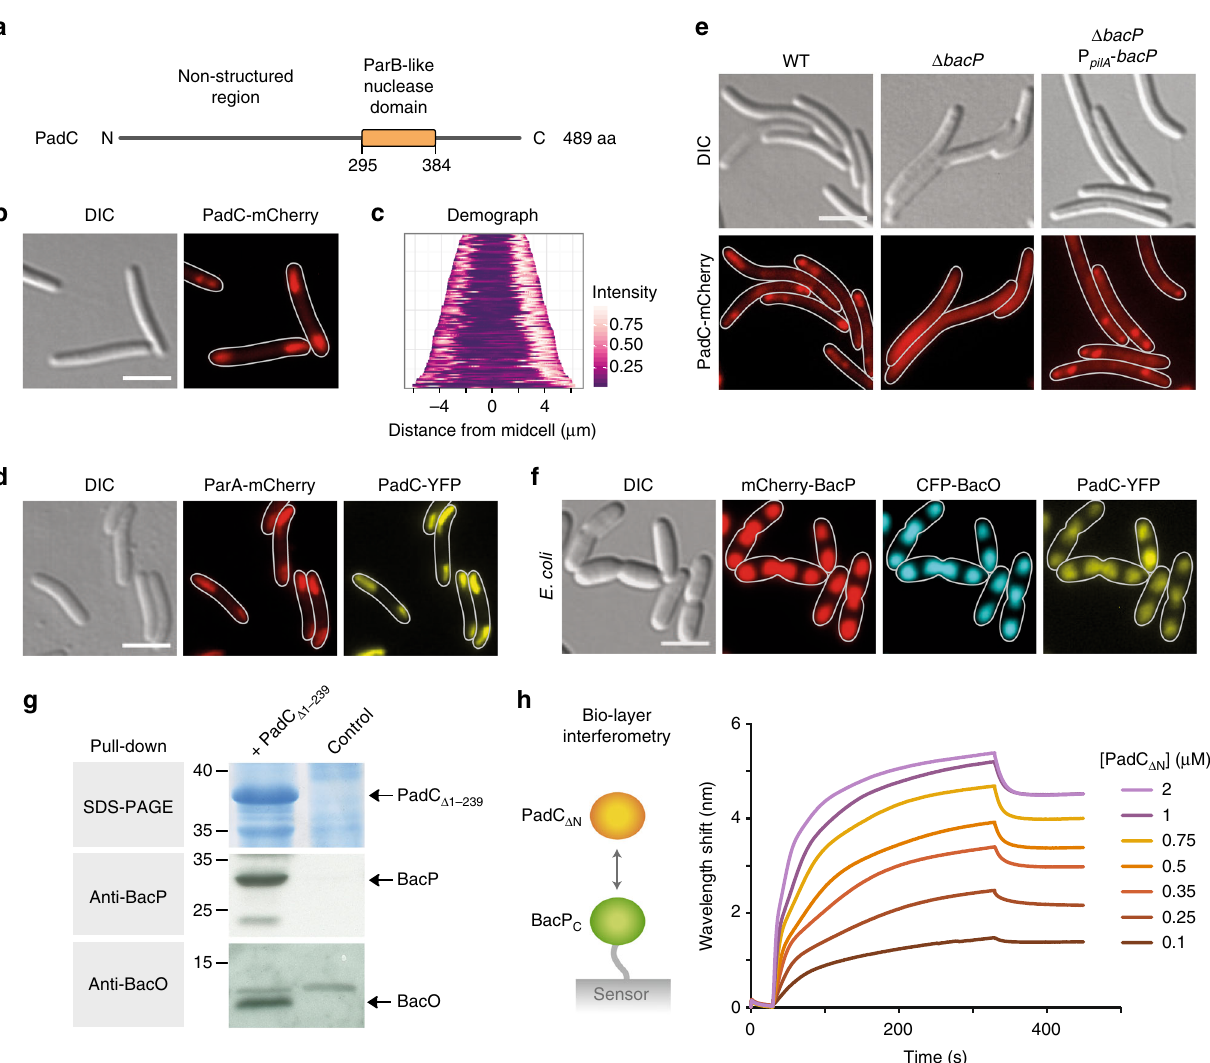
Fig. 3 BacP interacts with the ParB-like nuclease domain-containing protein PadC. a Domain organization of PadC. The ParB-like nuclease (ParB C ) domain is indicated in orange. Numbers indicate its position within the polypeptide chain. b Subcellular localization of PadC in M. xanthus . Cells of strain LL134 (P cuoA -padC-mCherry ) were induced overnight with 200 µ M CuSO 4 and analyzed by DIC and fl uorescence microscopy (bar: 3 µ m). c Demograph showing the subcellular distribution of PadC-mCherry in strain LL134 (see panel b ; n = 109 cells). d Colocalization of PadC with ParA in M. xanthus . Strain LL201 (P parA - parA-mCherry P van -padC - eyfp ) was induced for 2 h with 5 µ M vanillate before imaging (bar: 3 µ m). e Dependence of PadC localization on the presence of BacP. Cells of strains LL116 ( padC - mCherry ), LL130 ( Δ bacP padC-mCherry ), and LL135 ( Δ bacP P pilA -bacP padC-mCherry ) were analyzed by DIC and fl uorescence microscopy (bar: 3 µ m). f Heterologous reconstitution of the BacP · BacO · PadC complex in E. coli . Cells of E. coli BL21(DE3) bearing plasmids pLL54 (P T7 - mCherry-bacP cfp-bacO ) and pLL101 (P T7 - padC-eyfp ) were induced for 1.5 h with 0.5 mM IPTG before imaging. (bar: 3 µ m). The PCC for the mCherry-BacP and PadC-YFP signals is 0.92 ± 0.03 ( n = 50 cells). g Co-puri fi cation of BacP and BacO with PadC. A whole-cell lysate of wild-type strain DK1622 was incubated with Ni-NTA beads loaded with puri fi ed His 6 -PadC Δ 1-239 (+PadC). After isolation of the beads, bound protein was eluted and subjected to SDS – PAGE and to immunoblot analysis with anti-BacP and anti-BacO antibodies, respectively. A reaction with beads not pre-incubated with puri fi ed protein served as a control. A molecular mass standard (in kDa) is given on the left. Arrows indicate the positions of the target proteins. Full scans of the SDS-gel and the Western blots are shown in Supplementary Fig. 14. h Bio-layer interferometric analysis of the interaction between PadC and BacP. Sensors loaded with biotinylated BacP Δ 1 − 115 (BacP C ) were probed with the indicated concentrations of PadC Δ 1-281 (PadC Δ N ). The interaction kinetics were followed by monitoring the wavelength shifts resulting from changes in the optical thickness of the sensor surface during association or dissociation of the analyte. The extent of non-speci fi c binding of PadC Δ N to the sensor surface was negligible (Supplementary Fig.